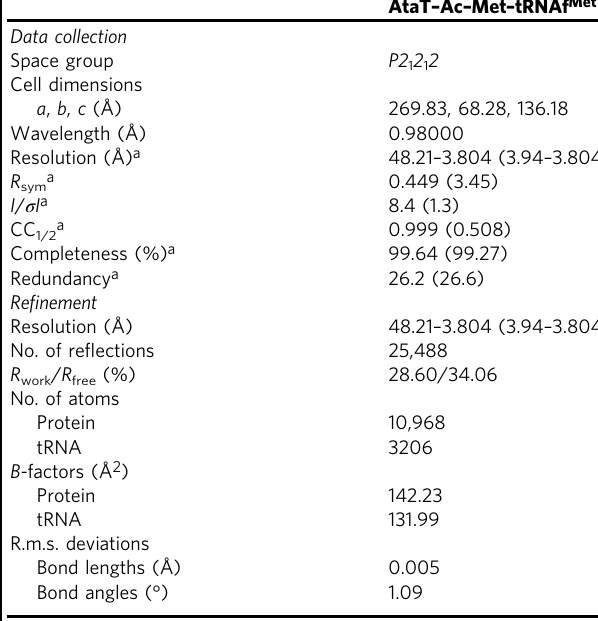
Table 1 Data collection and re fi nement